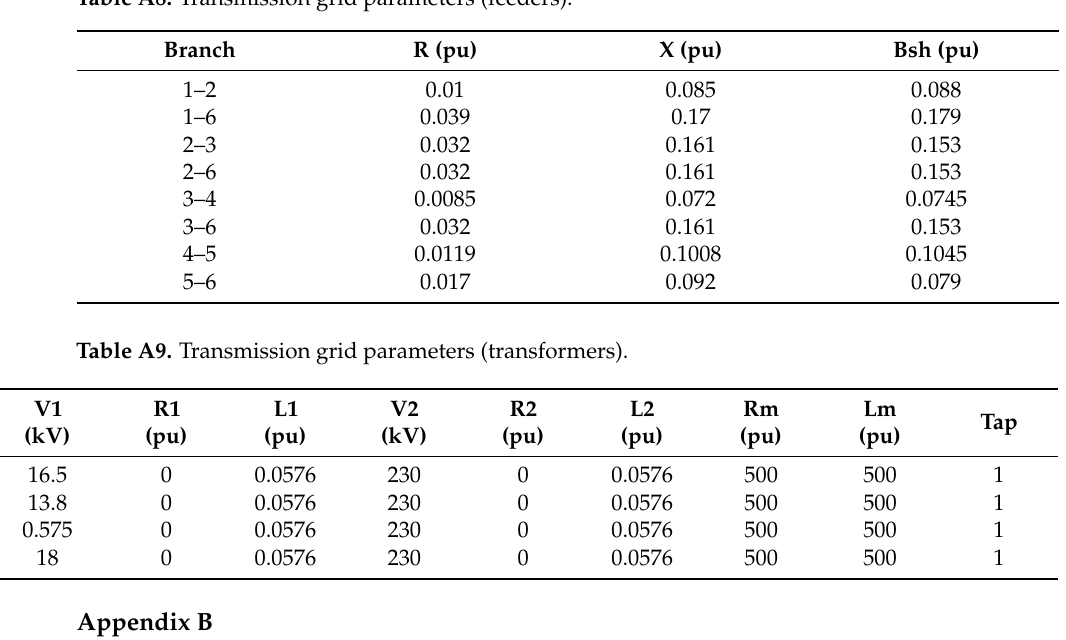
Table A8. Transmission grid parameters (feeders).